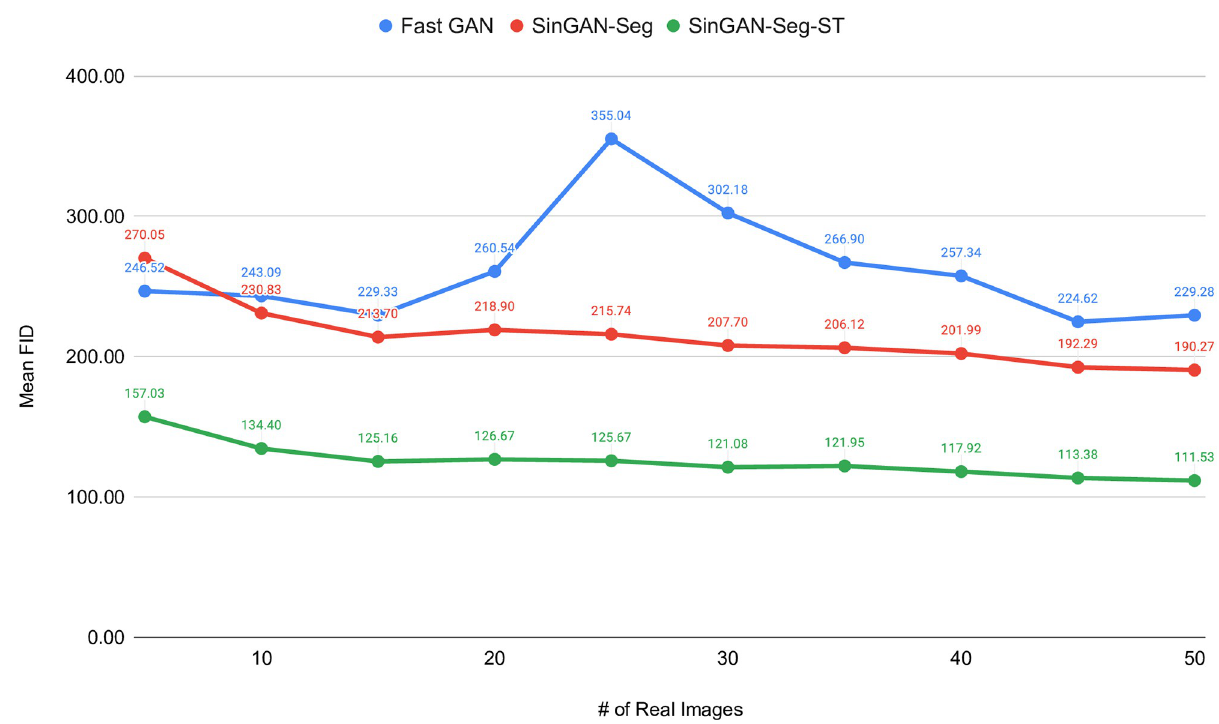
Fig 13. FastGAN versus SinGAN-Seg and SinGAN-Seg-ST. SinGAN-Seg-ST represents SinGAN-Seg with style transfer of 1: 1000.